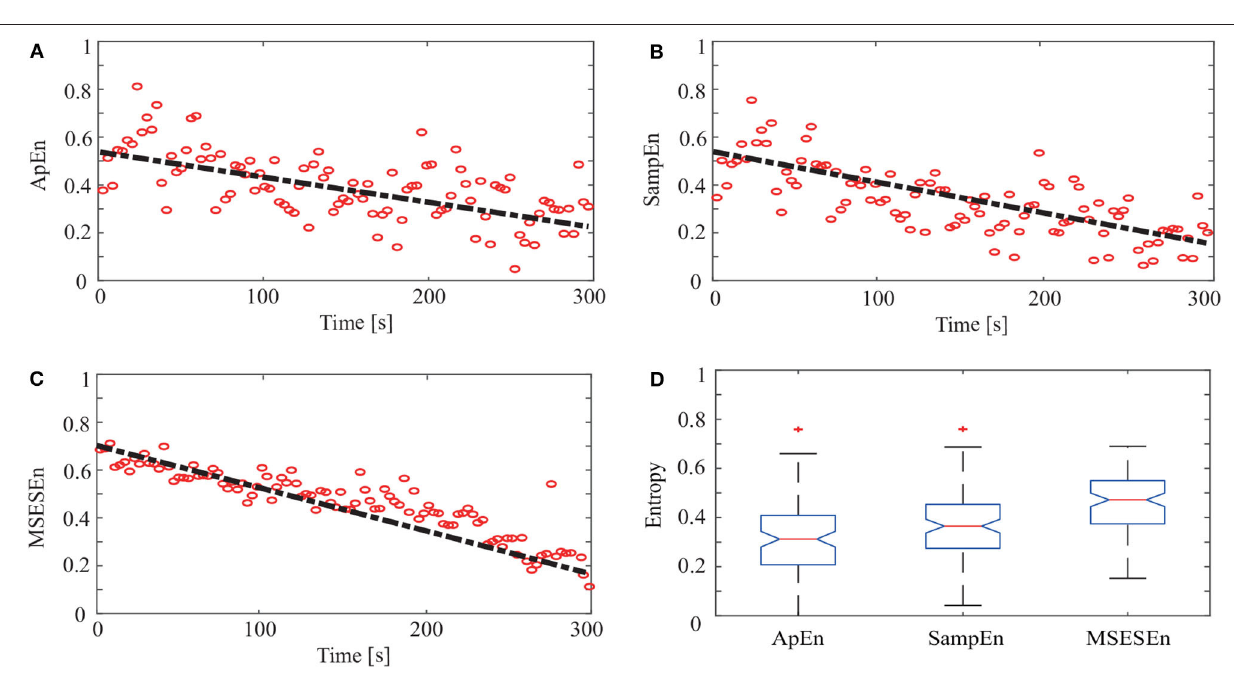
noise may remain in the signals when summing up and